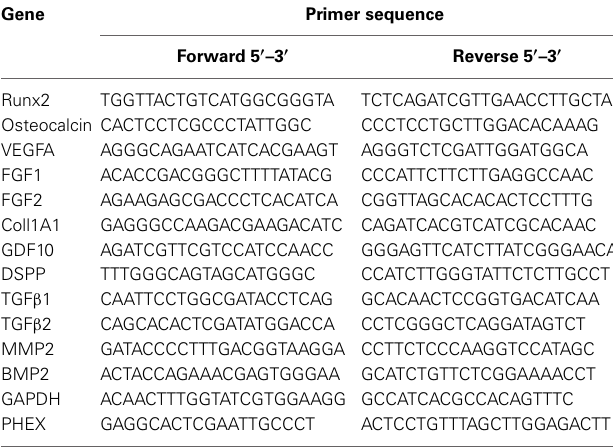
Table 1 | Gene specific primers.